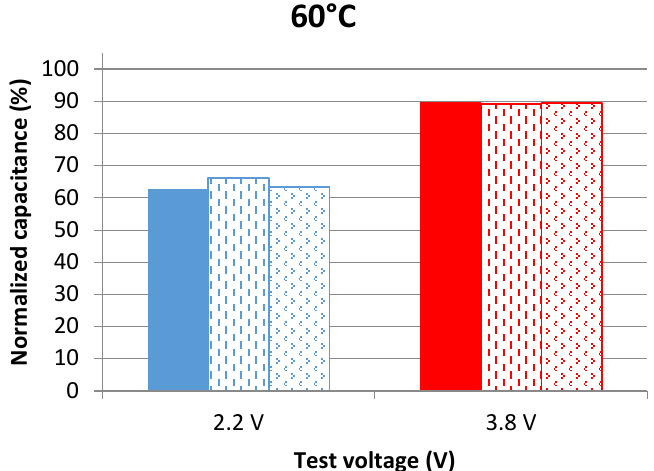
Figure 1. Capacitance evolution of cells aging at 2.2 V and 3.8 V at 60 °C after 109 days of calendar aging. The results are found from measurements in the frequency domain at 25 °C.